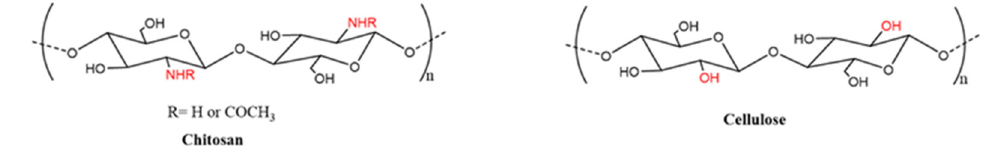
Figure 8. Chemical structures of chitosan and cellulose. Reprinted with permission from Ref. [99]. Copyright 2021, MDPI.